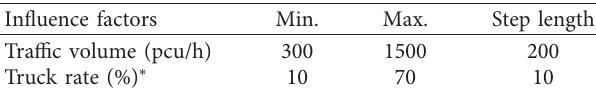
Table 4: Design of influencing factor